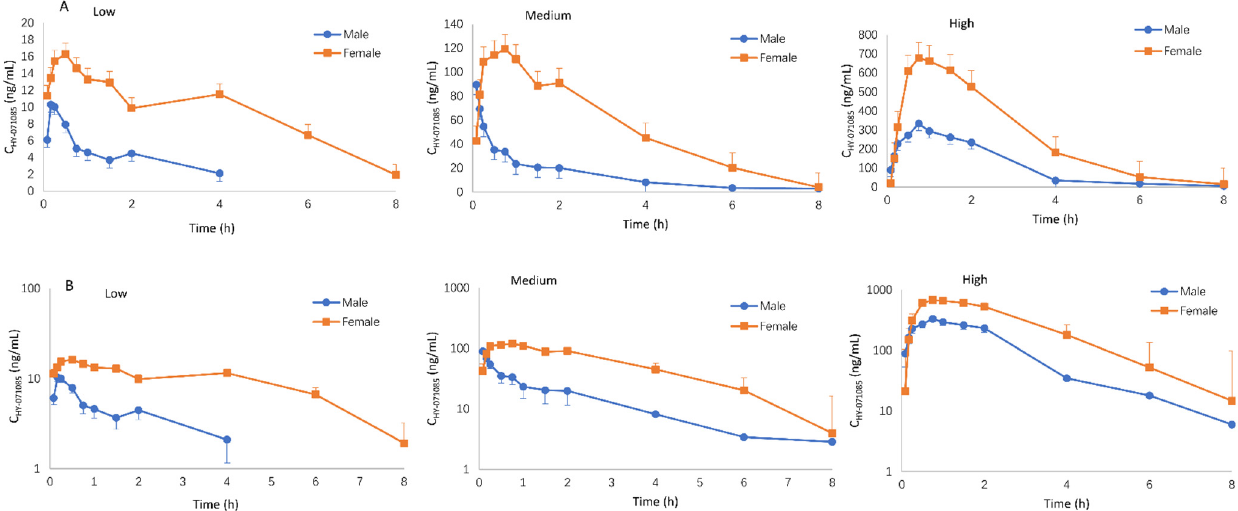
Figure 2. Mean plasma concentration time curve of HY-071085 after the single-dose intragastric administration of low (3.25 mg/kg), medium (6.5 mg/kg) and high (13 mg/kg) doses of HY-071085 in rats. ( A ) Constant coordinates; ( B ) semilogarithmic coordinates.